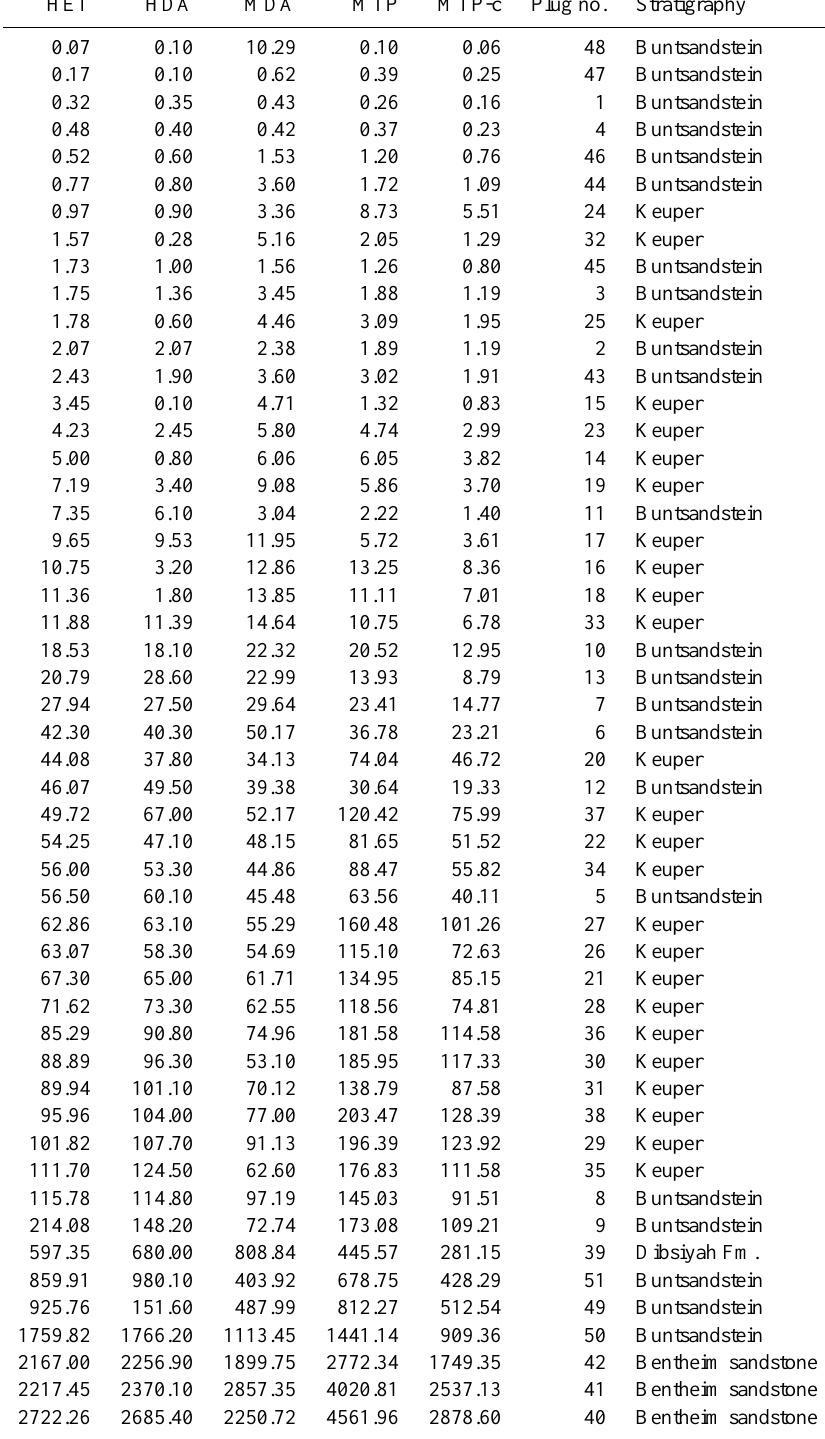
Table 1. Permeability data set of 51 sandstone sample plugs, measured with four different devices: the Hassler cells of the ErgoTech gas per- meameter (HET) and the gas permeameter in Darmstadt (HDA), and the minipermeameters New England Research TinyPerm II (MTP) and Miniperm Darmstadt (MDA). According to Table 2, MTP permeabilities have additionally been corrected for unconfined sample geometries (MTP-c). Permeability values are given in